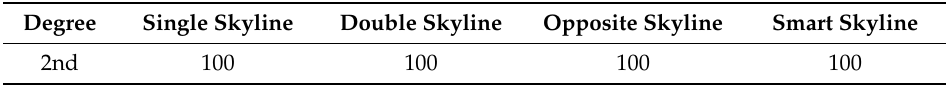
Table 22. Polynomial curve-fitting on the synthetic Dataset III.